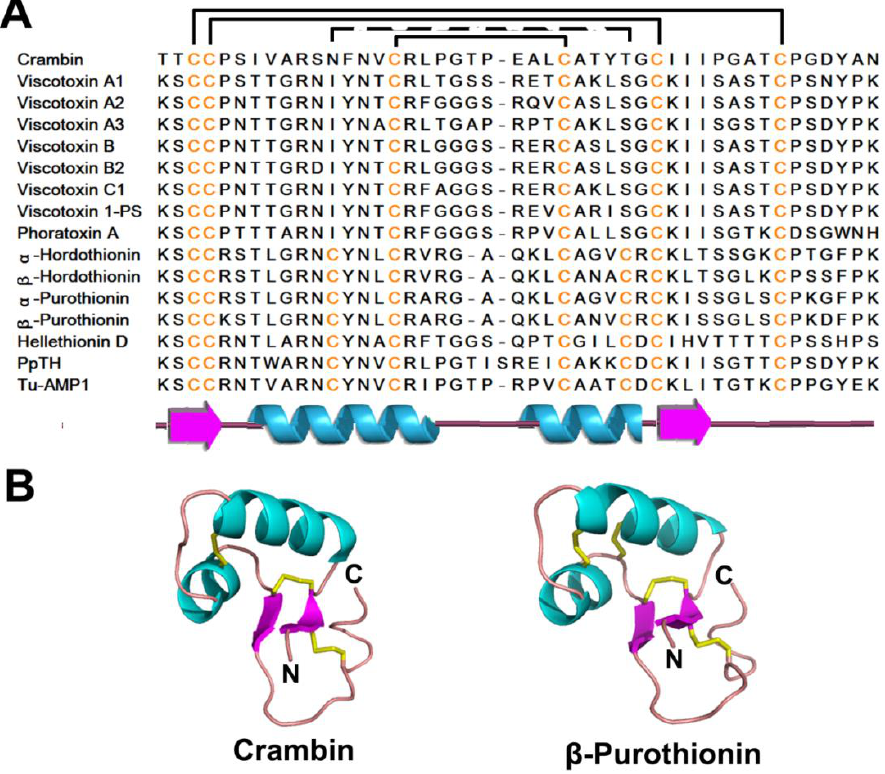
Figure 1. Sequences ( A ) and structures ( B ) of representative thionins. The secondary structure is represented by different colors: cyan-α helix; magenta-β strand; pink-random coil and yellow-disulfide